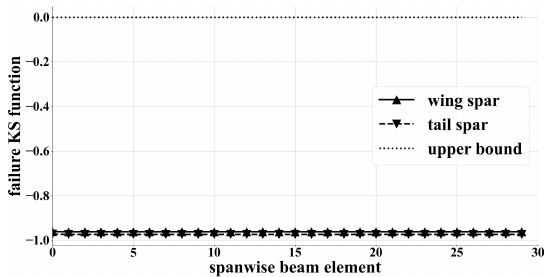
Figure 25. KS failure function for wing and tail